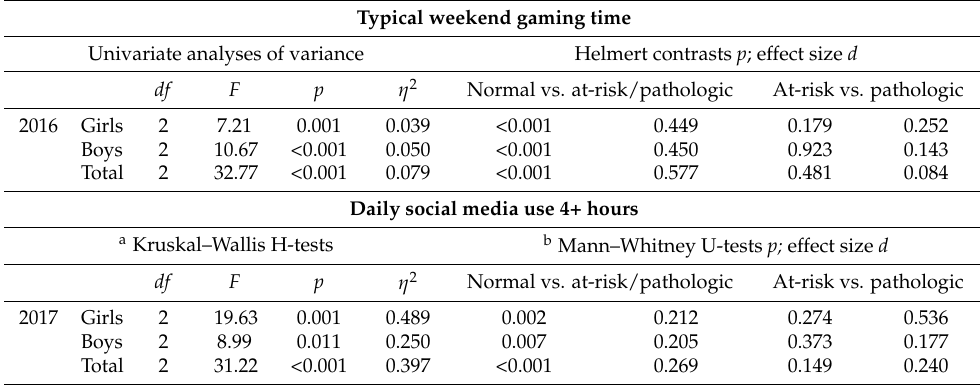
Table 6. Time spent with gaming (2016 sample) and social media (2017 sample): results of significance tests and effect sizes for Table 5.